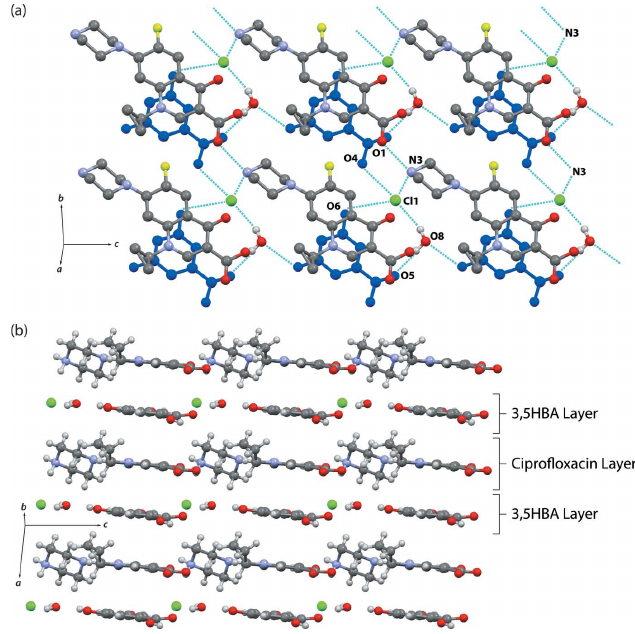
Figure 6 Intermolecular hydrogen-bonding motifs in (II) highlighting the role of the chloride ion and water molecule in bridging ciprofloxacin and 3,5HBA (blue). Hydrogen atoms are omitted for clarity. ( b ) The crystal packing of (II) showing the alternating layered